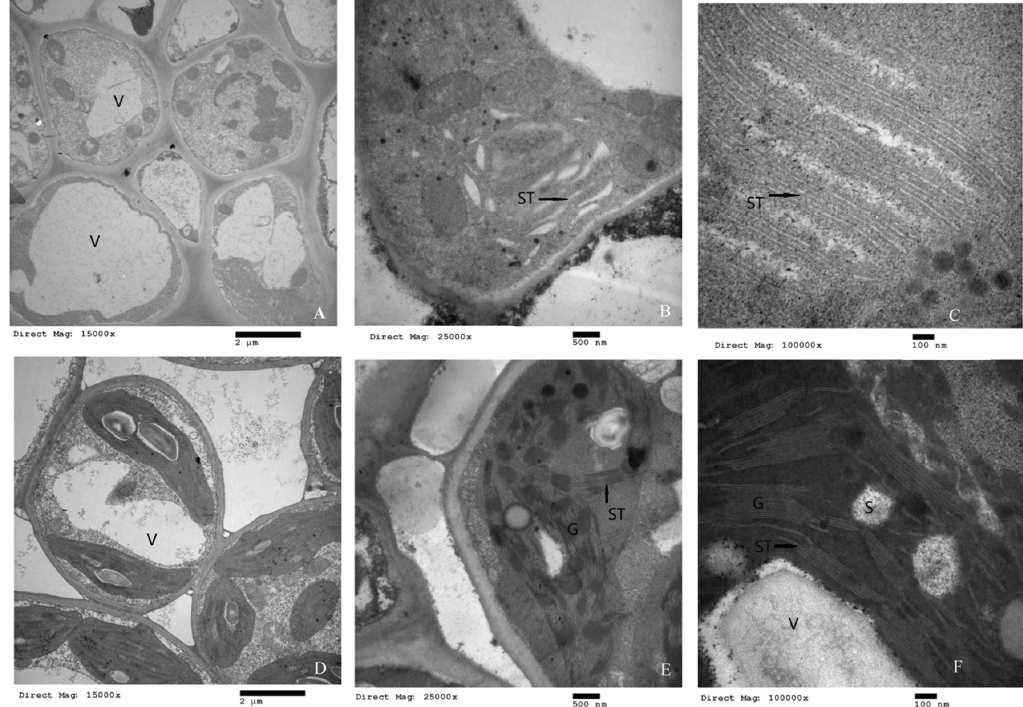
Figure 3. Comparison of chloroplast ultrastructures of ( A – C ) Ulmus pumila ’Jinye’ and ( D – F ) Ulmus pumila L. Note: ( A – C ) show the microstructure of chloroplasts with different magnification (15,000×, 25,000×, 100,000×) of Ulmus pumila ’Jinye’; ( D – F ) show the microstructure of chloroplasts with different magnification (15,000×, 25,000×, 100,000×) of Ulmus pumila L.; G—Granum; ST—Stoma thylakoid; S—Starch; V—Vacuole.